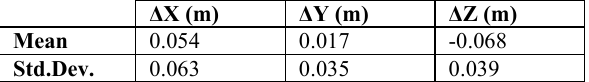
Table 7 Comparison between the coordinates of the control points measured on the field and the coordinates of the same points estimated in the NRTK processing.